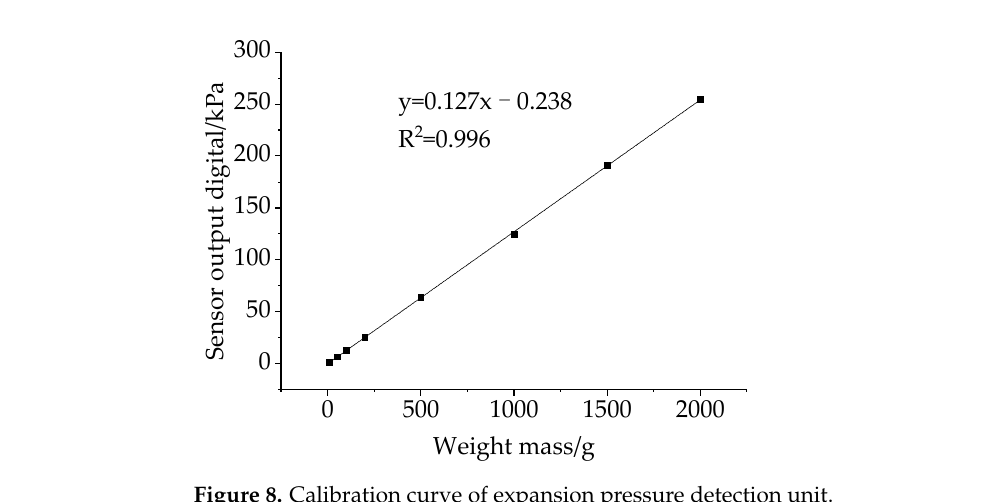
8 of 15 Figure 7. Measurement chart of swelling pressure probe. 3. Results